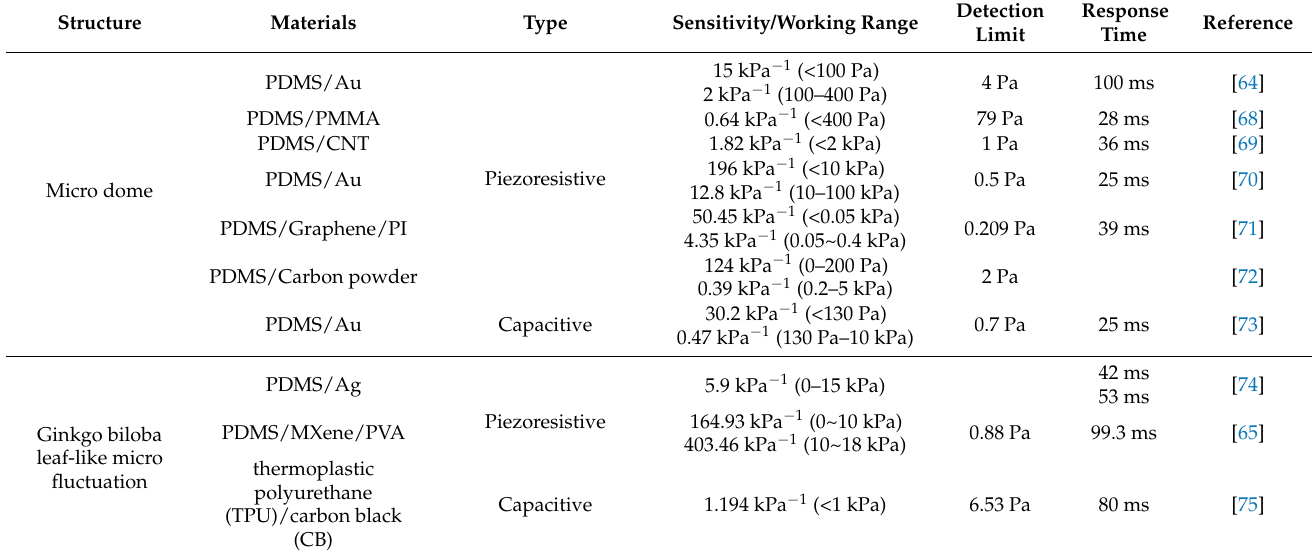
Table 3. The summary of sensor performances with micro fluctuation